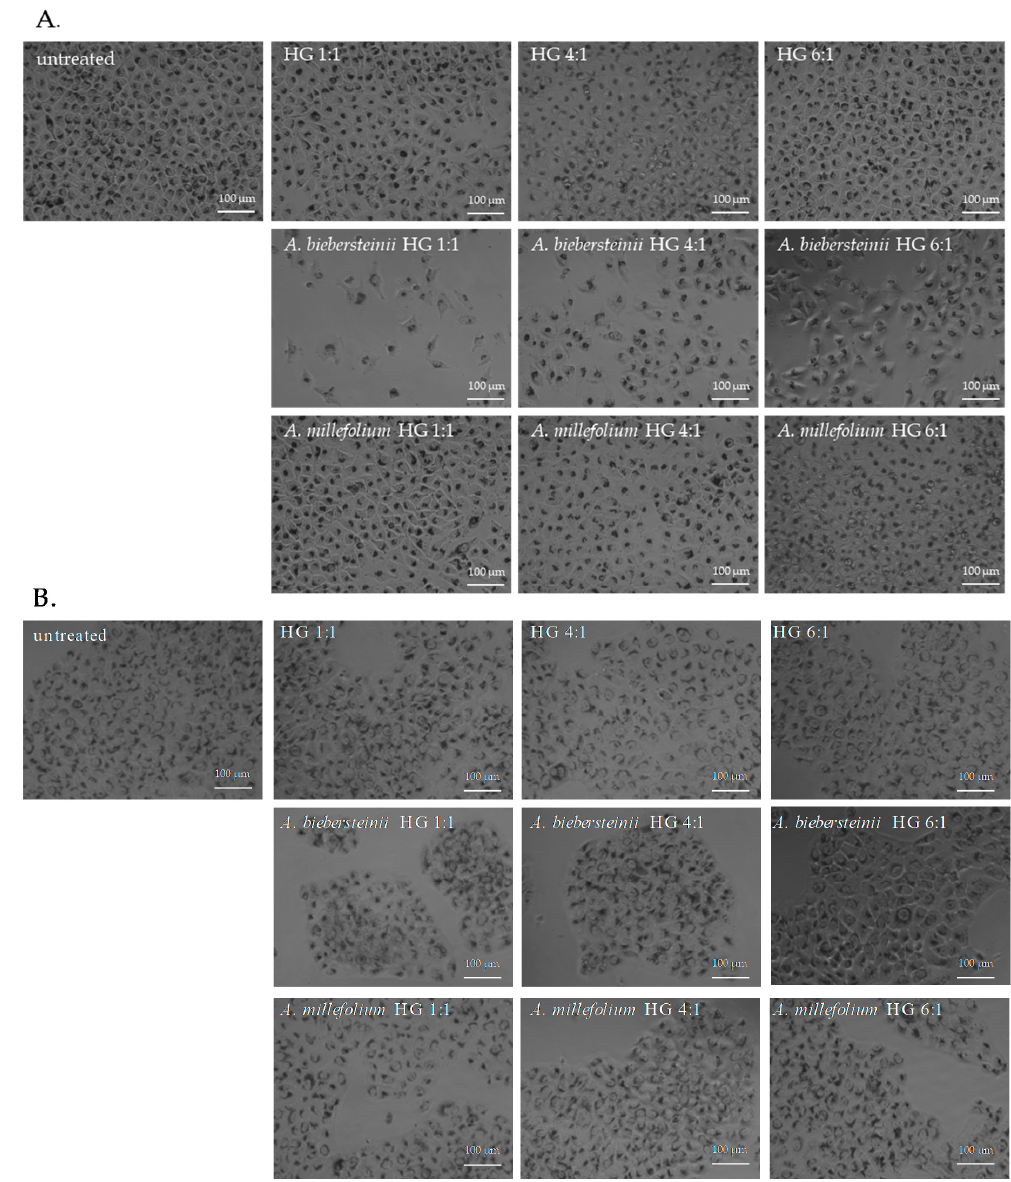
Figure 3. Morphology of A375 ( A ) and HaCaT ( B ) cells treated for 48 h with tested extracts or appropriate solvents at 2.5% concentration; the cells were stained with neutral red; pictures are representative for three experiments, magnification 4×, scale bar = 100 μ m. representative for three experiments, magnification 4 × , scale bar = 100 µ